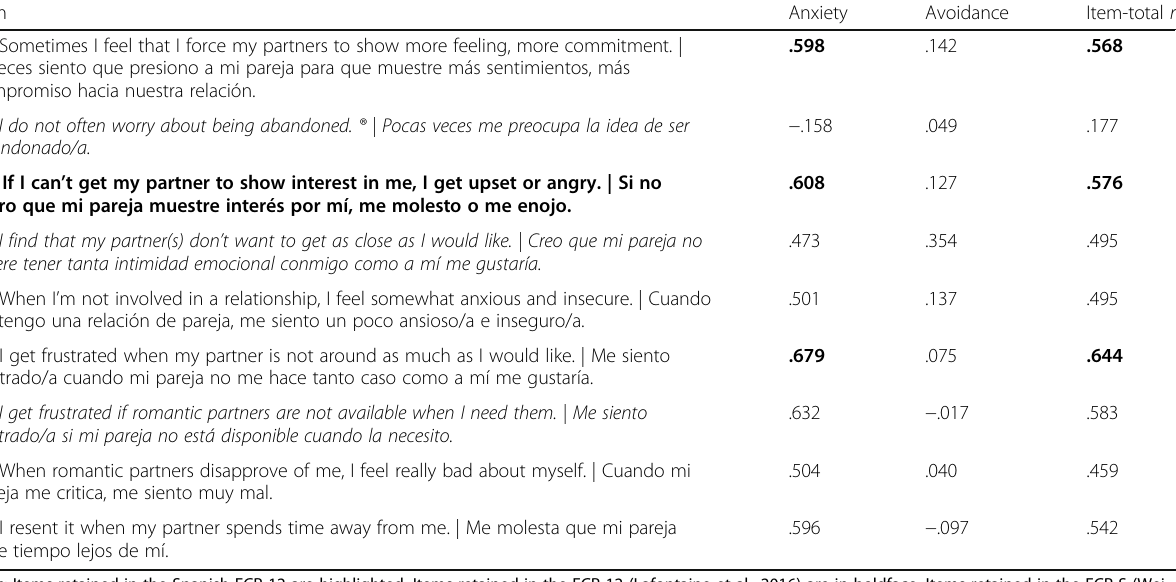
Table 4 Saturation coefficients and item-total correlations for the 36 items in sample 1 (Continued) Item